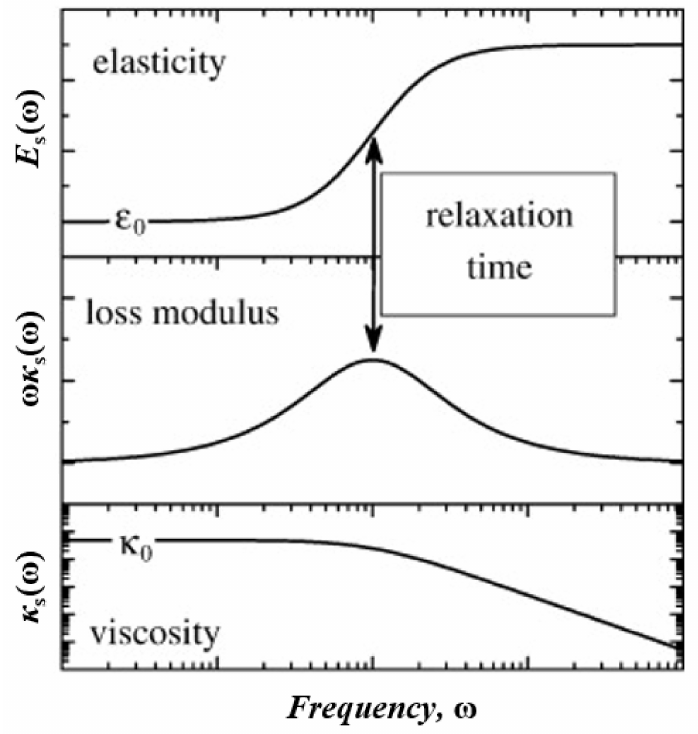
Figure 2. Sketch of the typical material response for a viscoelastic layer undergoing a single relaxation process upon the application of a dilational stress. Adapted from Mendoza et al. [30], with permission from Elsevier, Copyright